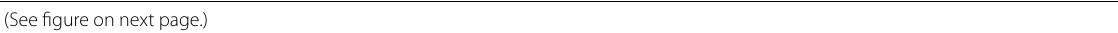
figure on next Fig. 2 a NCCT axial image at the level of rectal surgical interference showed surgical clips with no abnormality detected, b Fused PET- CT confirmed and revealed no FDG-active lesions denoting no residue or local recurrence. c CECT mediastinal window showed subcarinal as well as right hilar enlarged lymph nodes, d Fused PET-CT axial image confirmed and revealed hypermetabolic active lymph nodes (SUVmax measures 17.9). e NCCT showed right basal pulmonary 4 cm soft tissue density mass lesion. f Fused PET- CT axial image confirmed and revealed right basal + pulmonary hypermetabolic active deposit (SUVmax reaches 15). g NCCT axial image revealed C2 osteolytic lesion with extra osseus soft tissue component, h Fused PET–CT image confirmed FDG-overactive lesion destructing the anterior neural arch of C2 (SUVmax measures 10) as well as avid right deep cervical LN. i NCCT serial axial bone window images showed osteolytic lesions at the spinous process of L2 vertebra as well as right iliac bone, j Fused PET–CT images confirmed and revealed overactive bony deposits (SUVmax measures 10 & 16